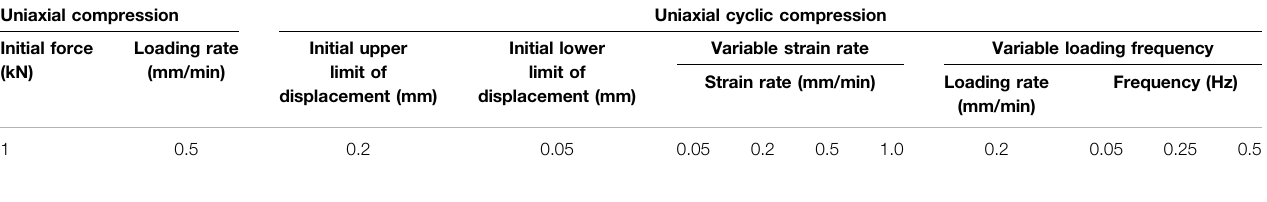
TABLE 1 | Testing parameters of rock-like material specimens containing fi ssures of different geometric